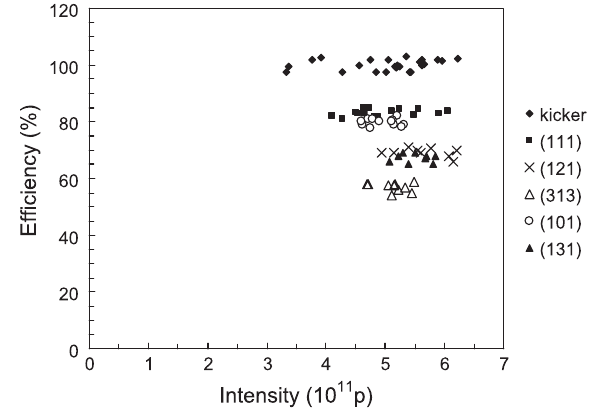
FIG. 5. The comparison of the efficiency of the beam deflec- tion by different crystallographic planes with the extraction by the beam-kicker magnet efficiency.